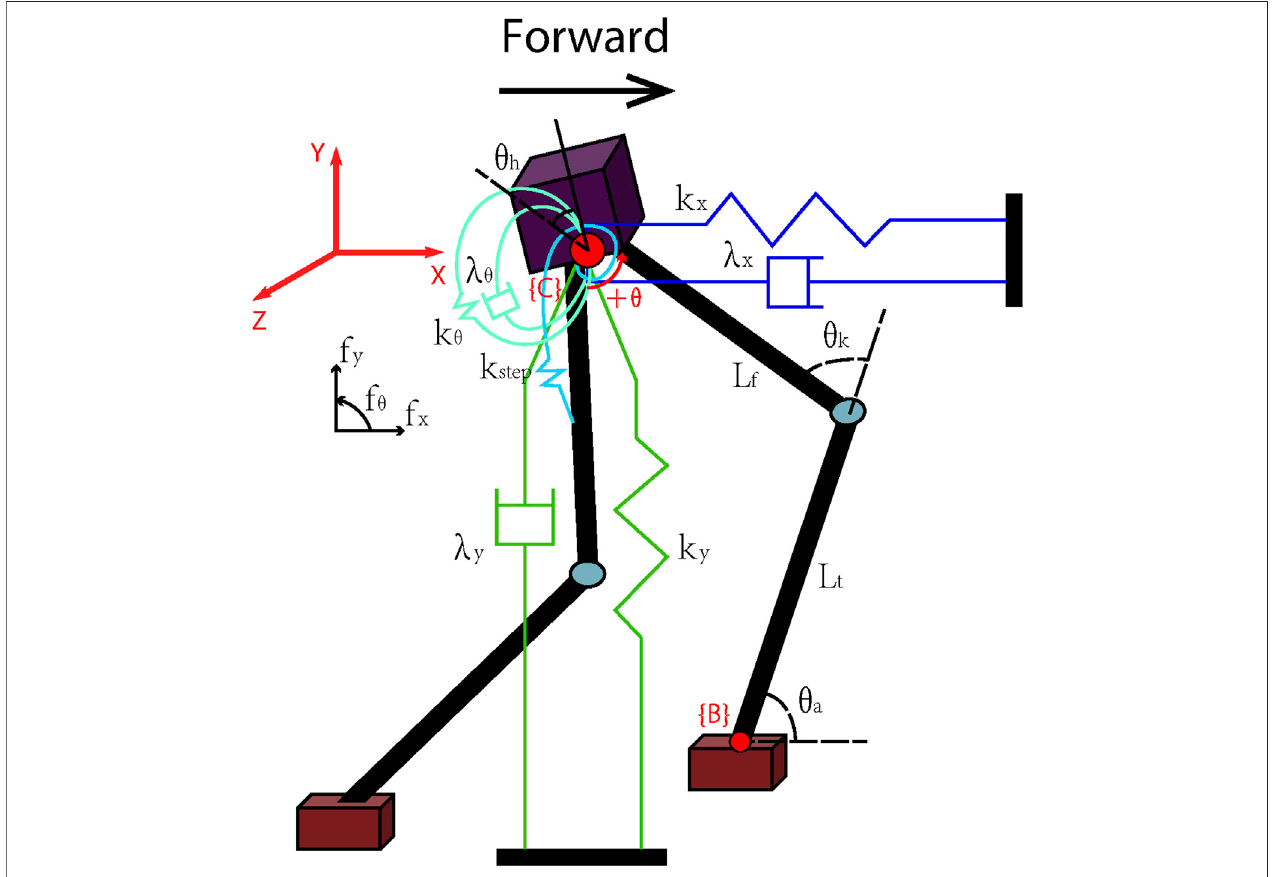
FIGURE 2 | The virtual model in our simulation. We attach linear springs and dampers to the hip position of the individual as the granny walker mechanism, to maintainaconstantheight,andthedog-trackbunnymechanismappliesavirtualforceintheforwardhorizontaldirectiontoobtainthedesiredvelocity.Inaddition,ithasa torsionalspringandarotarydamperactingonthehipjointtokeeptheupperbodystraightinthestandingphase,whileinthestepphase,thehipjointonlyhasatorsional springwith k step springstiffnesstoswingtheleg.Thewallwhichthespringandthedamperareattachedisvirtual,andonlyexiststocreatethevirtualforce f x , f y ,and f θ .Each componentoftheindividualisachangeablegenotype, such asthestiffness ofthespring k x , k y , k θ ,and k step ,theviscosity ofthedamper λ x , λ y ,and λ θ ,thelength of the femur L f and the tibia L t , and three dimensional sizes of the torso and the foot.